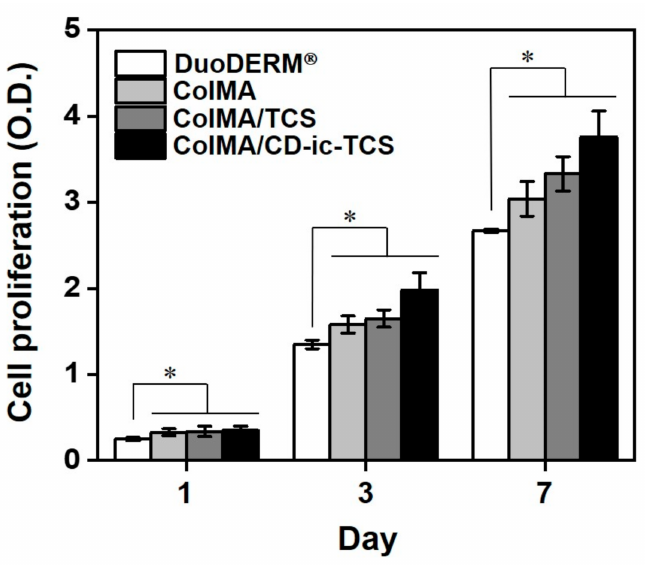
Figure 6. In vitro proliferation of NIH3T3 cells on DuoDERM ® , ColMA, ColMA/TCS, or ColMA- CD-ic-TCS for culture periods of 1, 3, and 7 days. ColMA—methacrylated collagen; ColMA/TCS— triclosan (TCS) incorporated ColMA; ColMA/CD-ic-TCS—HP- β -CD/TCS complex incorporated ColMA. This experiment was performed in triplicate ( n = 3). Results were expressed as mean ± standard deviation (* p <